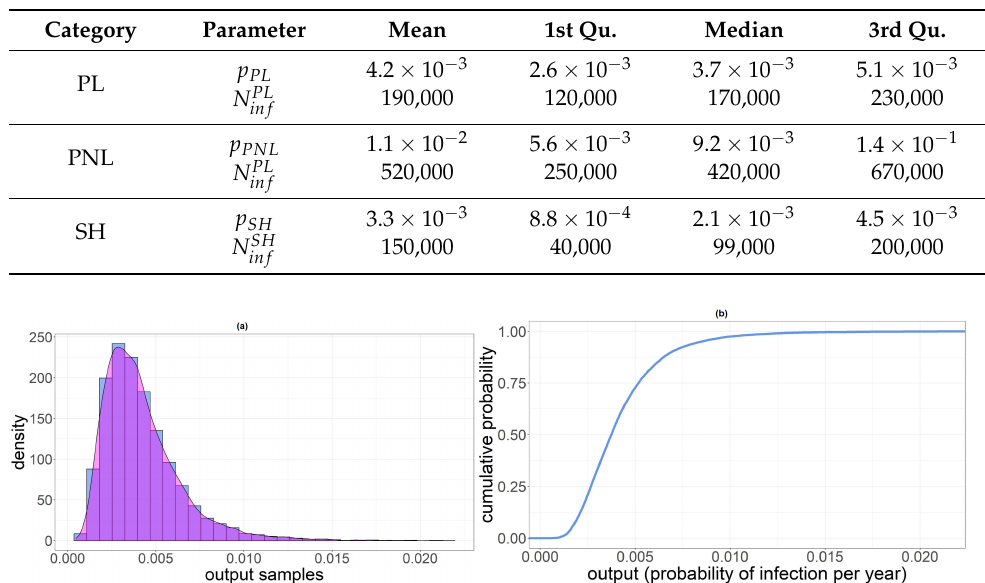
Table 7. Summary statistics of output samples.